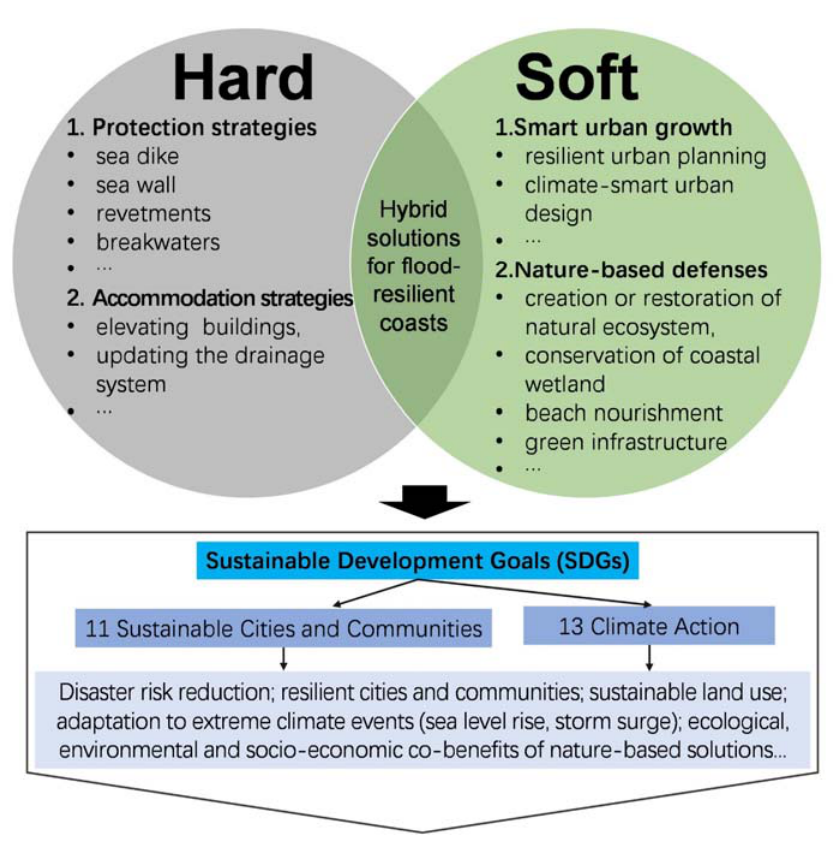
Figure 11. Hybrid approach for coastal flood resilience and adaptation. Our results suggest the importance of integrating both hard solutions and soft solutions for combating coastal flooding. Traditional hard defenses can be constructed in shorter timeframes, and take effect immediately. Soft solutions, such as nature-based coastal defenses, on the other hand, are more cost-effective, sustainable and eco-friendly. The hybrid approach is highly related to coastal sustainability, by contributing to the “climate actions” and “sustainable cities and communities” of the Sustainable Development Goals (SDGs).